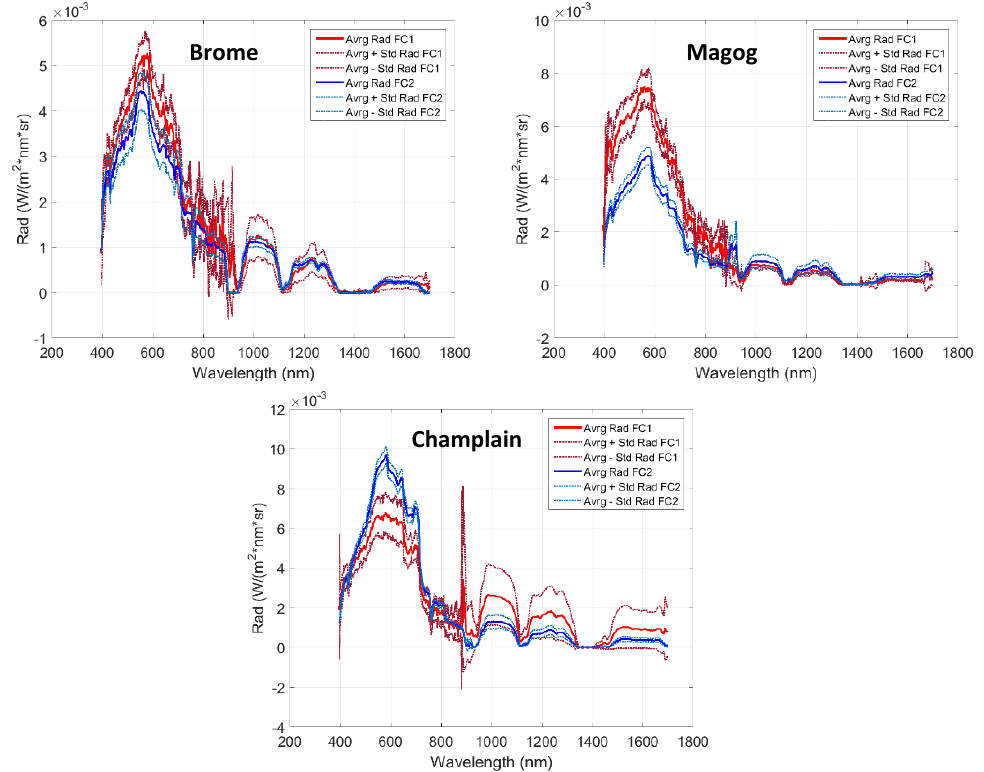
Figure 5. Hyperspectral radiance collected over the in situ measurements. Rad, Avrg, and Std refer, respectively, to radiance, average, and standard deviation. FC1 and FC2 refer, respectively, to field campaigns 1 and 2.